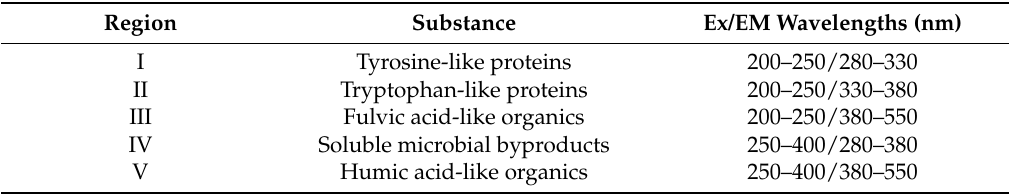
Table 1. Excitation and emission (Ex/Em) wavelengths for each fluorescence region. Region